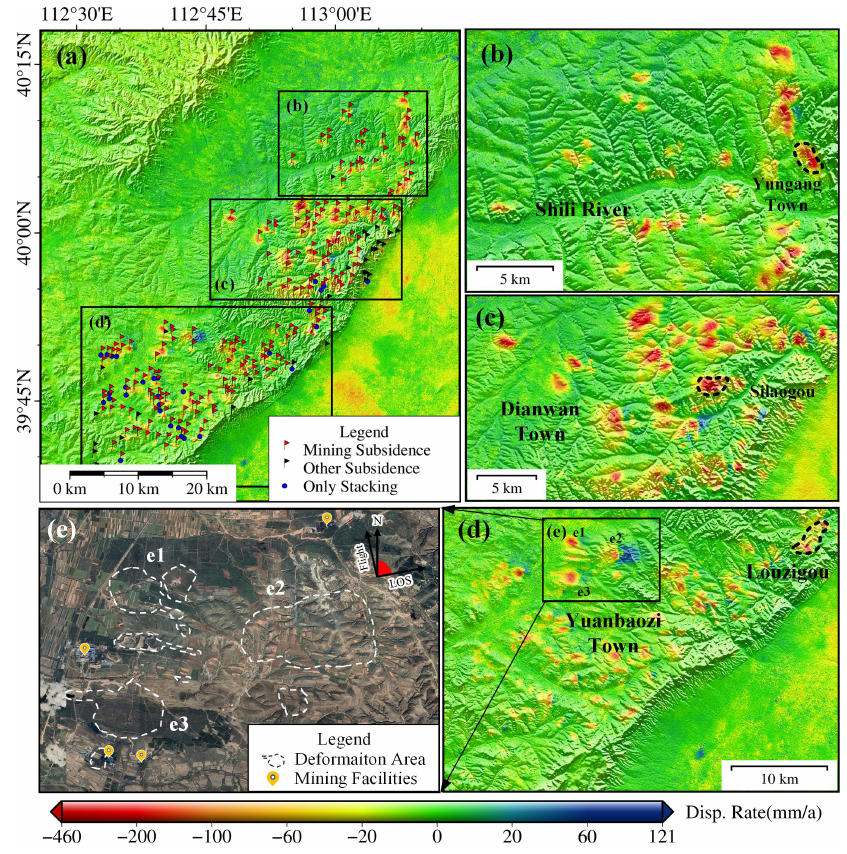
Figure 5. The stacking-InSAR results of the displacement rate: ( a ) is the stacking-InSAR result for the whole study area; ( b – d ) are enlarged views of the three zones in ( a ). The dotted lines in ( b – d ) are the positions of the deformation areas where the maximum displacement rate is located; ( e ) is the enlarged optical remote sensing data of the subsidence region.